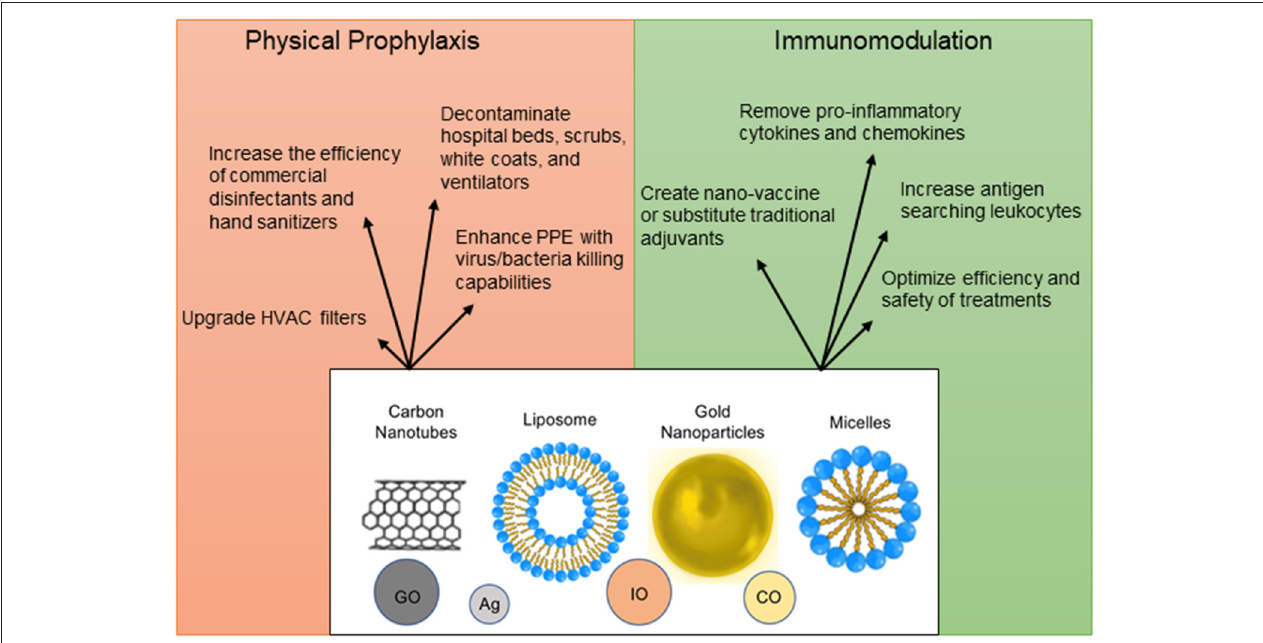
FIGURE 4 | Nanoparticle applications as prophylactic and therapeutic measures. Nanoparticles can be used in a plethora of ways for protection against infection, for immunomodulation, vaccine design, and optimization of detection methods. The structural design of nanomaterials is diverse and includes engineering of carbon nanotubes [Graphene Oxide (GO)], liposomes, micelles, precious metals [Silver (Ag), Copper Oxide (CO), and Iron Oxide